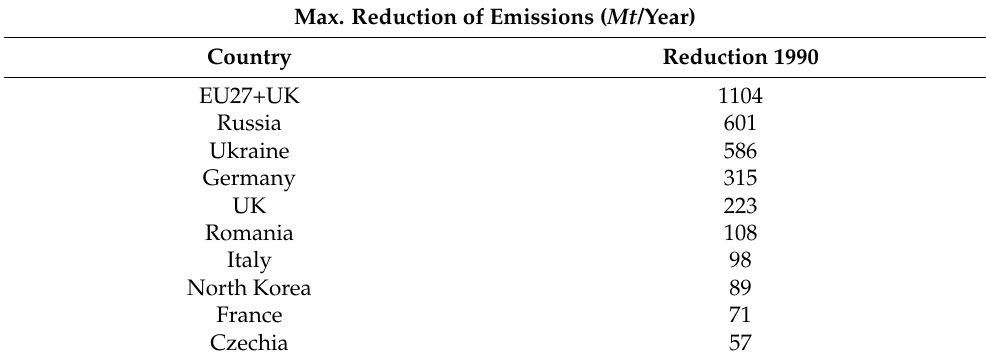
Table 3. Ten first countries with the greatest reduction in emissions. Own elaboration.